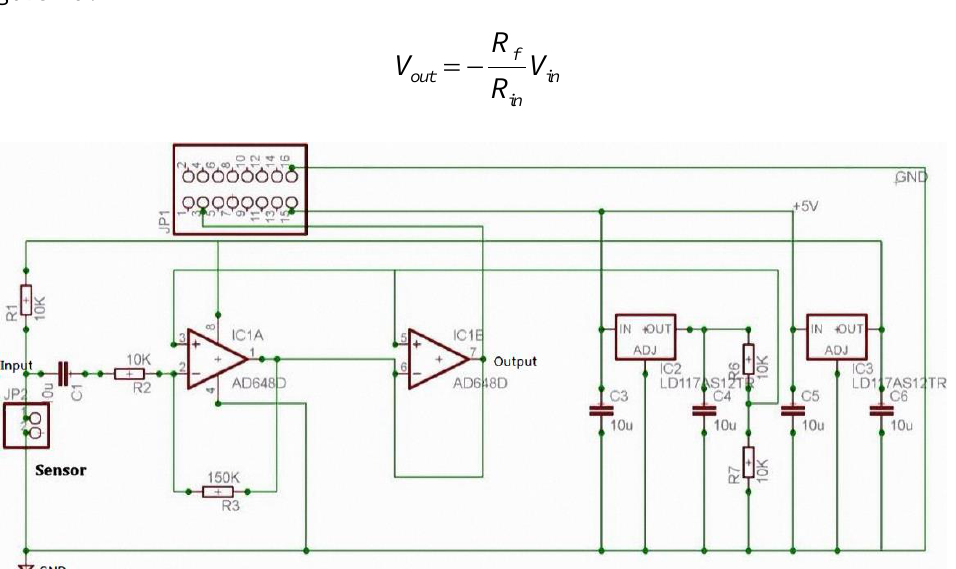
Figure 9. Respiratory sensor